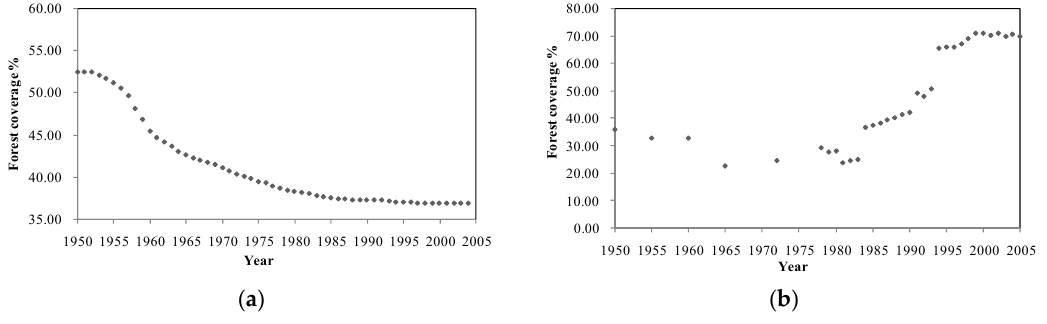
Figure 2. Forest coverage in ( a ) the Zagunao watershed and ( b ) the Meijiang watershed.